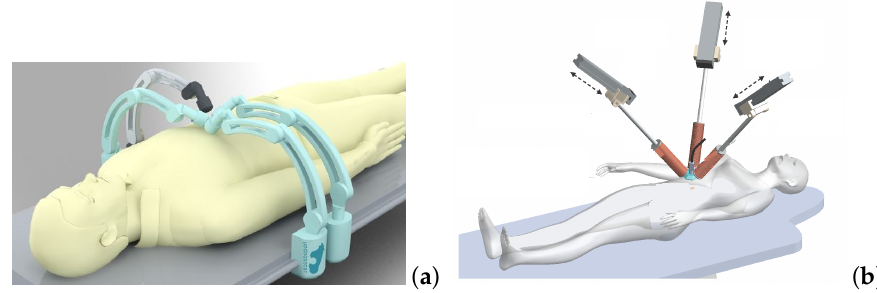
Figure 4. Examples of EMA systems with moving permanent magnets: ( a ) conceptual image of a rotating-permanent-magnet manipulator proposed by Fountain et al. [51], and ( b ) the Stereotaxis Niobe ® consisting of two robotically-controlled magnets next to the table.